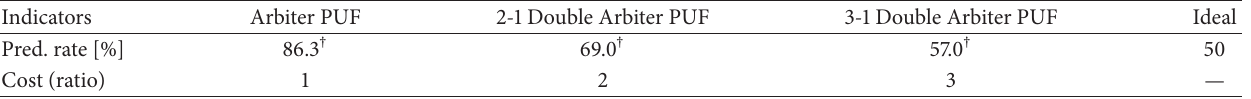
Figure 9: Design of the 3-1 Double Arbiter PUF on Xilinx Virtex-5 FPGA. SR-Latches as Arbiters are fabricated by pairing the NAND with LookUp Table (LUT).